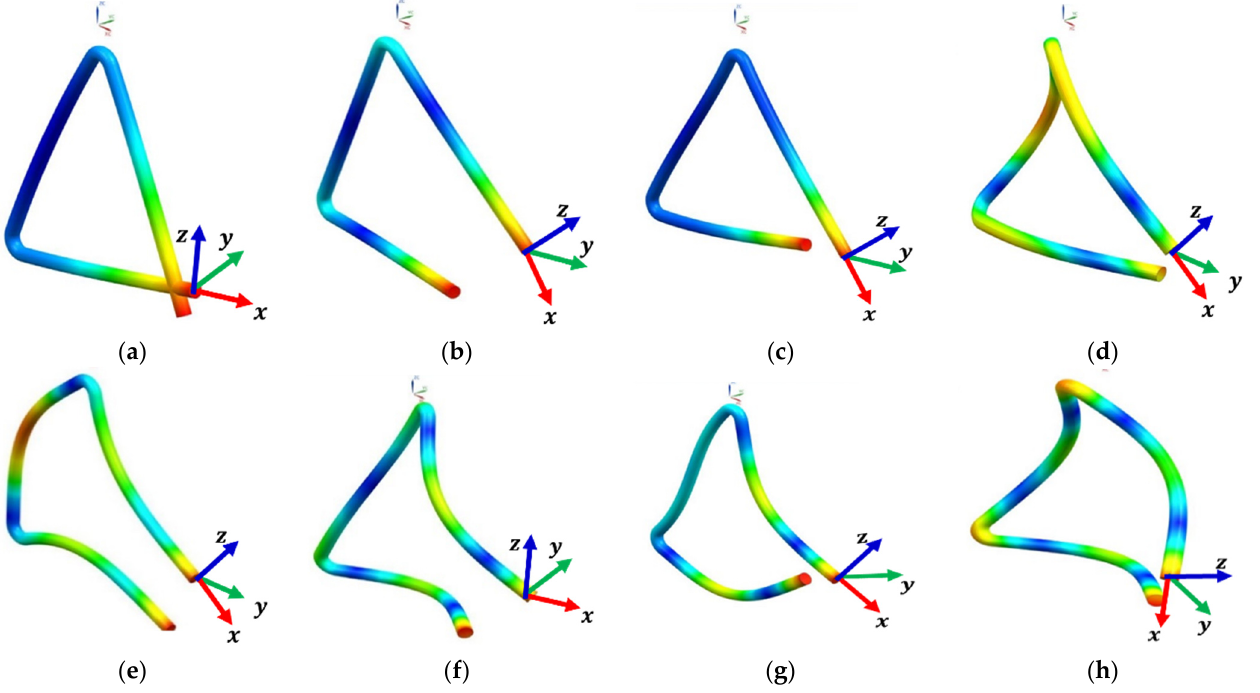
Figure 10. Vibration modes of the stainless steel triangle T1: ( a ) mode 1 (156 Hz); ( b ) mode 2 (162 Hz); (c) mode 3 (269 Hz); ( d ) mode 4 (805.285 Hz); ( e ) mode 5 (978.74 Hz); ( f ) mode 6 (1465.83 Hz); ( g ) mode 7 (1499 Hz); ( h ) mode 8 (1627 Hz). ( g ) mode 7 (1499 Hz); ( h ) mode 8 (1627